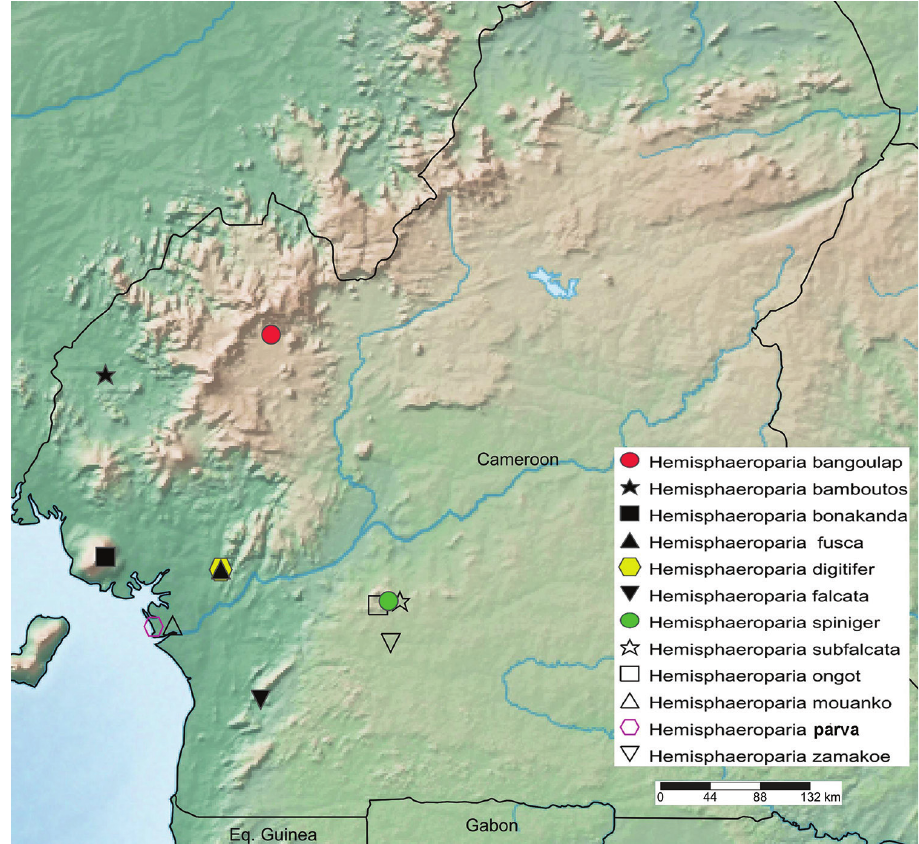
Figure 30. Distribution of the species of Trichopolydesmidae in Cameroon, arranged from north to south: Hemisphaeroparia bangoulap sp. n. ( 1 ), Hemisphaeroparia bamboutos sp. n. ( 2 ), Hemisphaeroparia bonakanda sp. n. ( 3 ), Hemisphaeroparia fusca sp. n. ( 4 ), Hemisphaeroparia digitifer sp. n. ( 5 ), Hemisphaeroparia falcata sp. n. ( 6 ), Hemisphaeroparia spiniger sp.n. ( 7 ), Hemisphaeroparia subfalcata sp. n. ( 8 ), Hemisphaeroparia ongot sp. n. ( 9 ), Hemisphaeroparia mouanko sp. n. ( 10 ), Hemisphaeroparia parva sp. n. ( 11 ), Hemisphaeroparia zama- koe sp.n. ( 12 ), Hemisphaeroparia integrata (Porat, 1894)(?) and ? Hemisphaeroparia parvula (Porat,